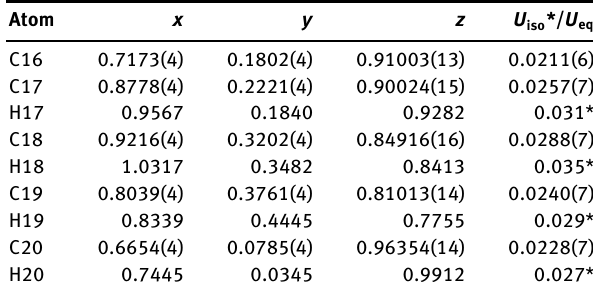
Table 2: Fractional atomic coordinates and isotropic or equivalent isotropic displacement parameters (Å 2